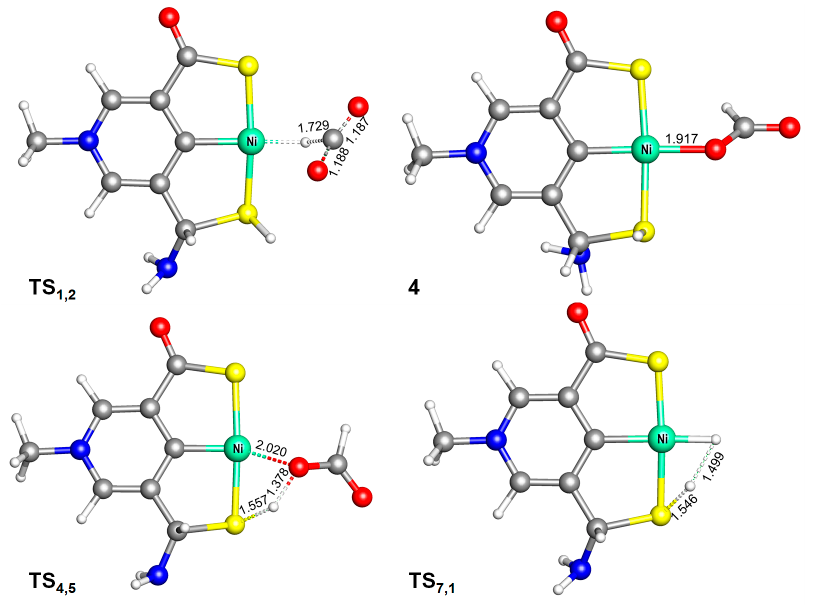
Figure 3. Optimized structures of TS 1,2 (673.2 i cm − 1 ), 4 , TS 4,5 (1614.2 i cm − 1 ), and TS 7,1 (1013.6 i cm − 1 ) in Cycle 1. Bond lengths are in Å.